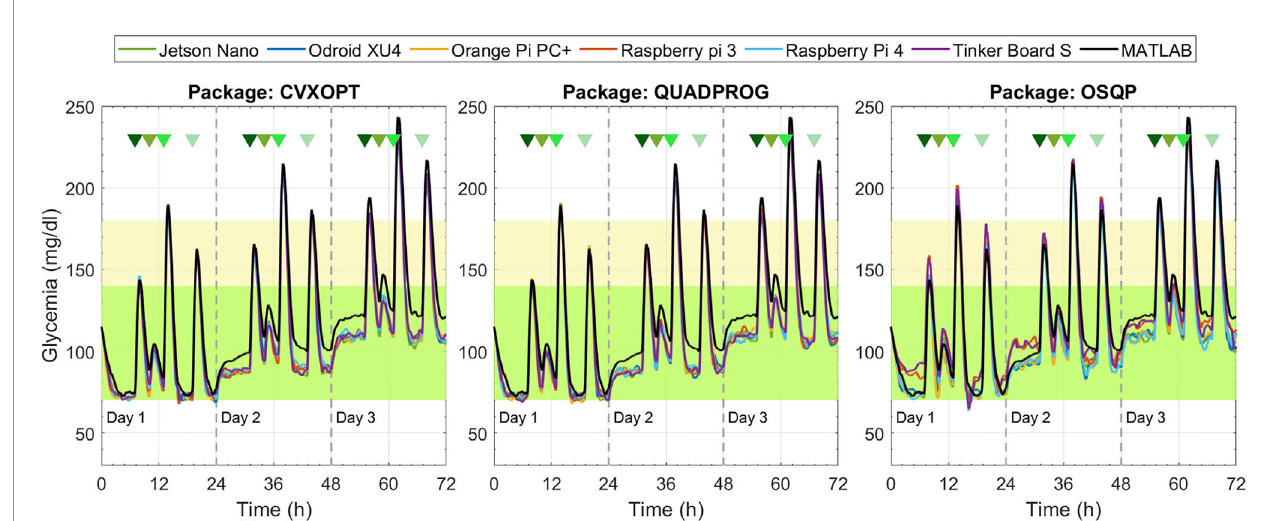
FIGURE 6 | Glycemia evolution under the ZMPC strategy with the three solver packages.